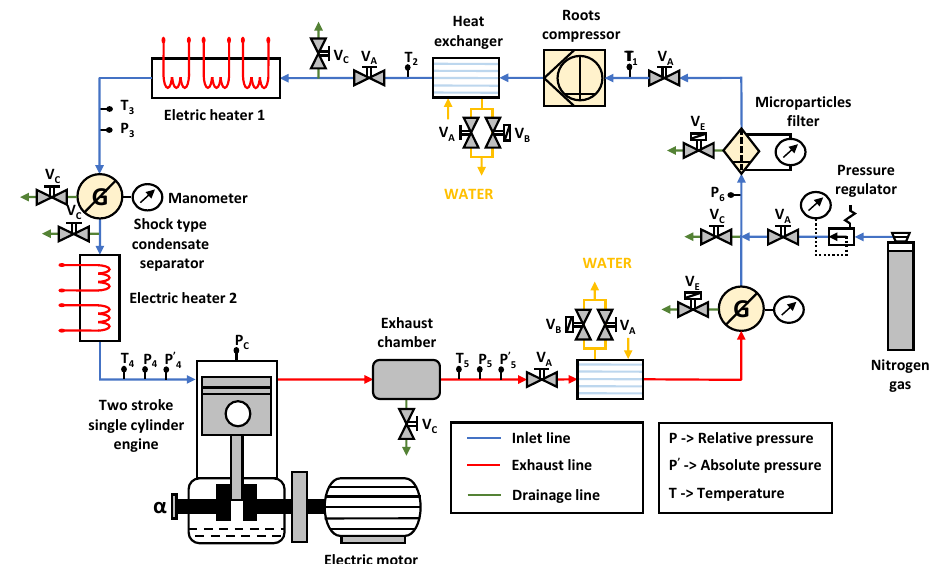
Figure 1. Scheme of the main gas circuit under an inert atmosphere configuration.